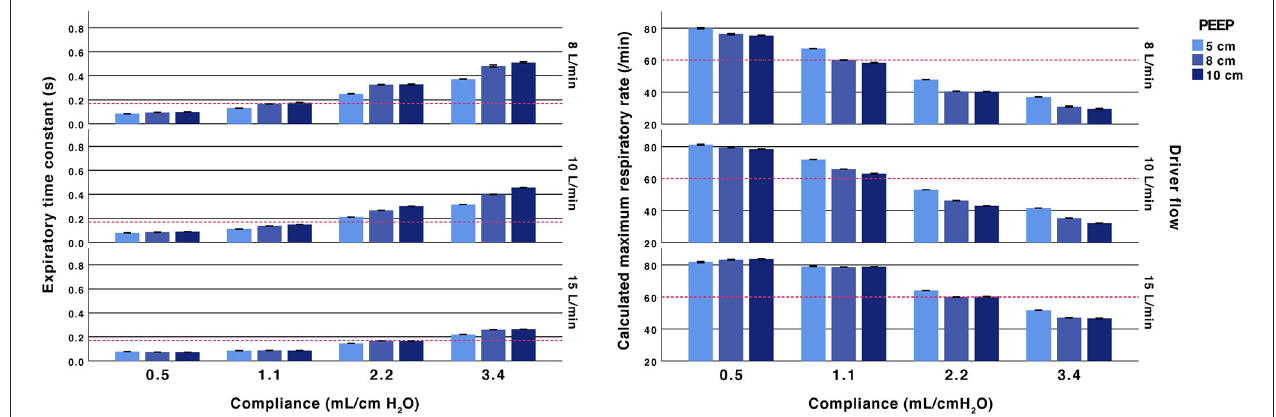
FIGURE 2 | Effect of fresh gas flow, PEEP and compliance. Expiratory time constants (left) and calculated maximum ventilatory rate (right). All test performed with an inspiratory pressure of 15cm H 2 O above PEEP and with an Rp50 airway resistor. Arbitrary reference lines at τ rs 0.17s represent a complete expiration time of 0.5s (3* τ rs) and a calculated maximum ventilatory rate of 60/min (fixed inflation time of 0.5s). The expiratory time constant increases with higher compliance, lower fresh gas flow and a higher PEEP.